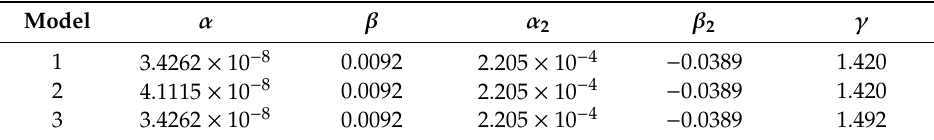
Table 2. Various degradation model parameters for ESS-FR battery